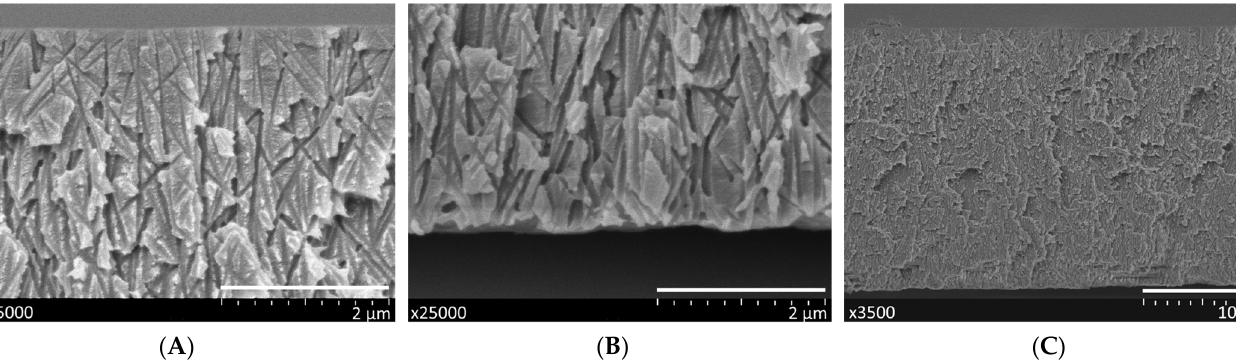
Figure 5. SEM images of a typical cross-section of TEM-1: the layers adjacent to sides a and b (images ( A ) and ( B ), respectively) and full thickness ( C ). Scale bars are shown in the frames.